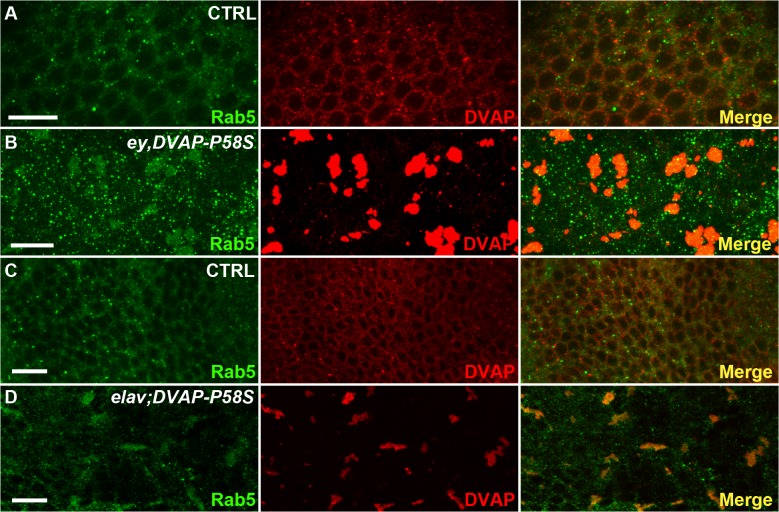
Abnormal accumulation of Rab5 in larval eye imaginal discs and brains expressing DVAP-P58S.(A) control ey-Gal4/+ eye imaginal discs and elav-Gal4/+ brains (C) immuno-stained with anti-DVAP and anti-Rab5 antibodies. Eye imaginal discs (ey,DVAP-P58S in B) and larval brains (elav;DVAP-P58S in D) expressing the pathogenic allele were stained with the same antibodies. In controls, DVAP and Rab5 are homogenously distributed throughout the cytoplasm but form large, overlapping aggregates in DVAP-P58S expressing cells. Scale bars: 10μm.